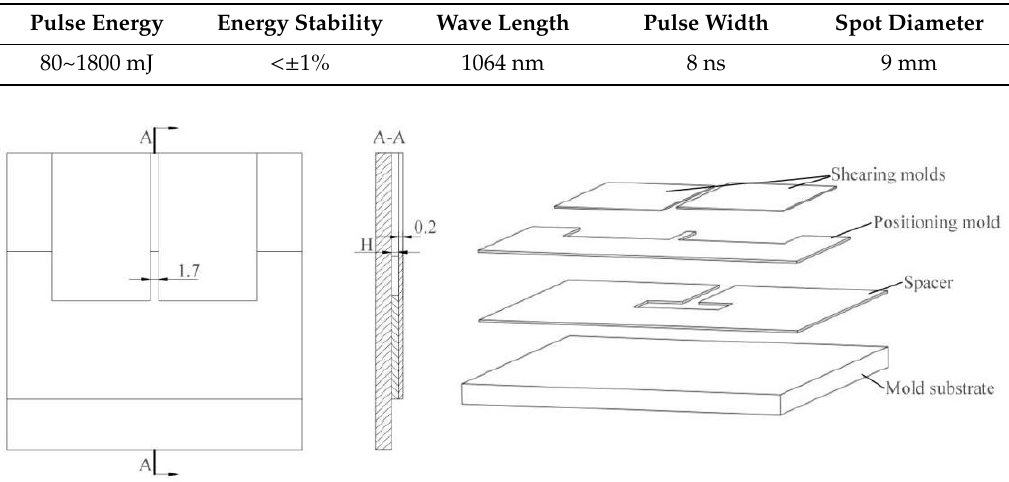
Table 1. Main parameters of INNOLAS Nd-YAG Spitlight 2000 laser.